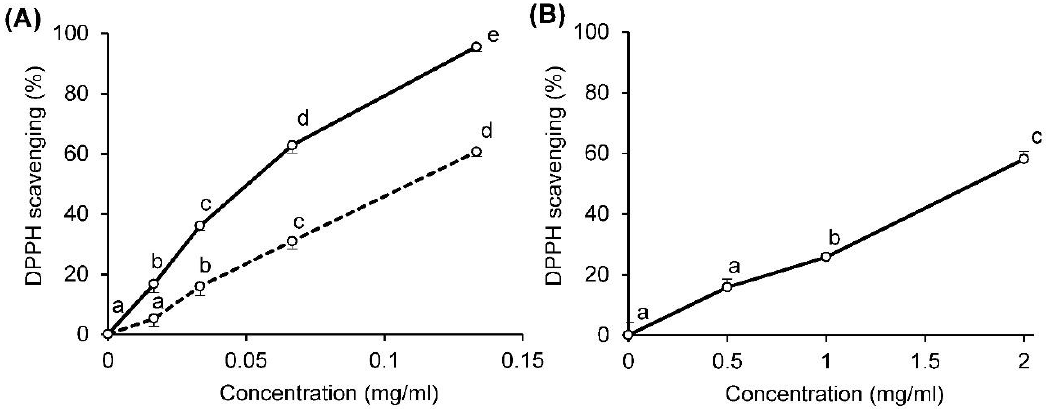
Figure 1. The DPPH scavenging activity of pectins EA-4.0 and EA-0.8 ( A ) in comparison with commercial apple pectin ( B ). Solid and doted lines in Figure 1A show pectins EA-4.0 and EA-0.8, respectively. Data are presented as the mean ± SD of three independent experiments. Different lowercase letters (a, b, c, d, e) for the same sample at different concentrations indicate significant differences ( p < 0.05, LSD test). Table 5. The DPPH scavenging activity of fireweed pectins in comparison with commercial apple pectin (АР) and trolox .